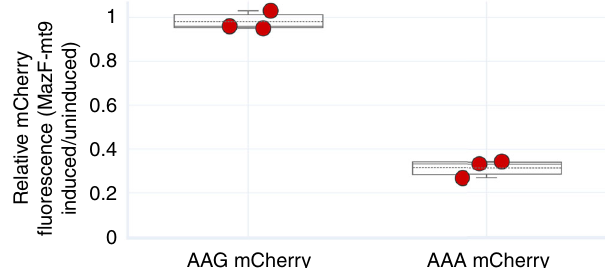
Fig. 8 MazF-mt9 translation inhibition is codon speci fi c. MazF-mt9 was co- expressed with two different versions of mCherry: one containing its lysine codons mutated to AAA (AAA mCherry) and the other to AAG (AAG mCherry). mCherry fl uorescence was measured 5 h after induction of MazF-mt9 and normalized against an uninduced ( − MazF-mt9) control. Each individual data point is derived from a biological replicate ( n = 3).